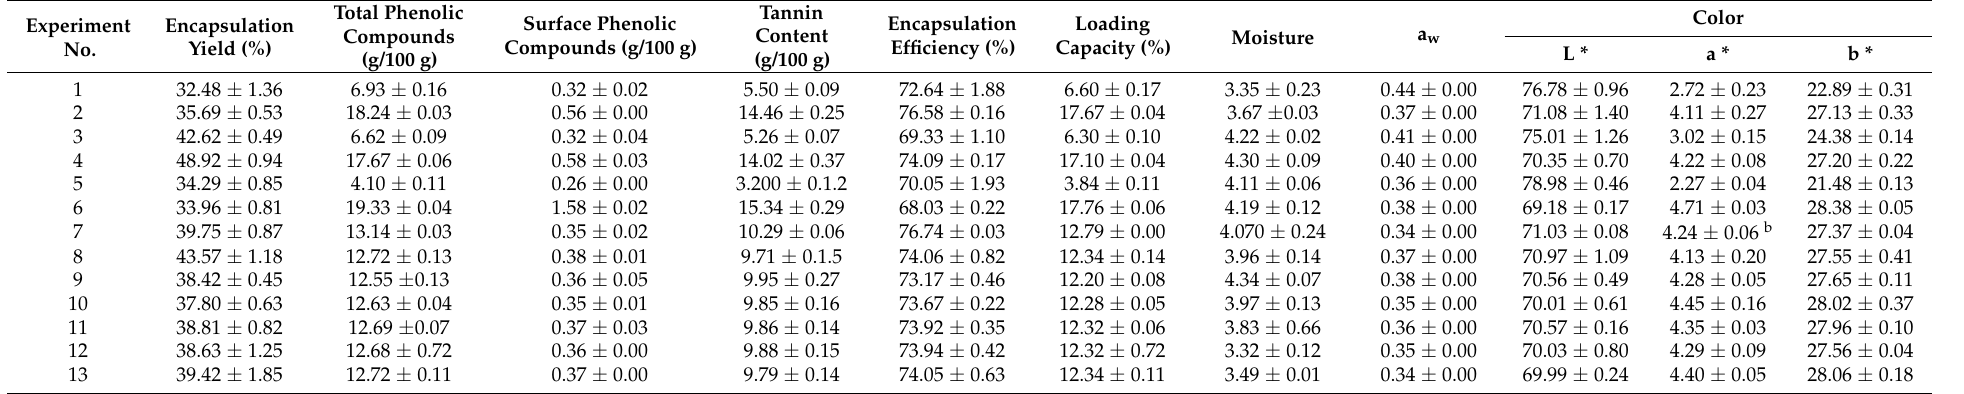
Table 2. Experimental results of quebracho extract microencapsulation by spray drying carried out according to the central composite design. Experiment